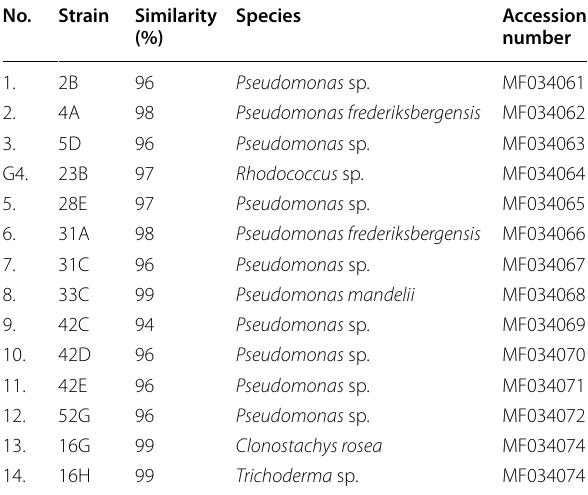
Table 3 Microorganisms able to biodegradation process isolated from Spitsbergen soil samples